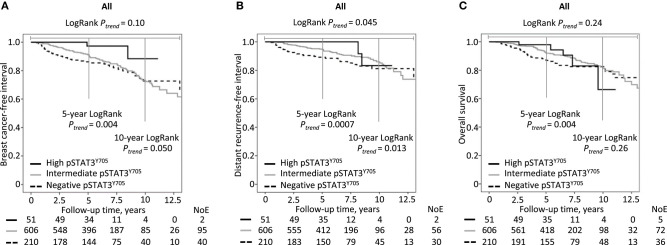
Kaplan-Meier estimates of (A) breast cancer-free interval, (B) distant metastasis-free interval and (C) overall survival in relation to pSTAT3Y705 level in all patients.